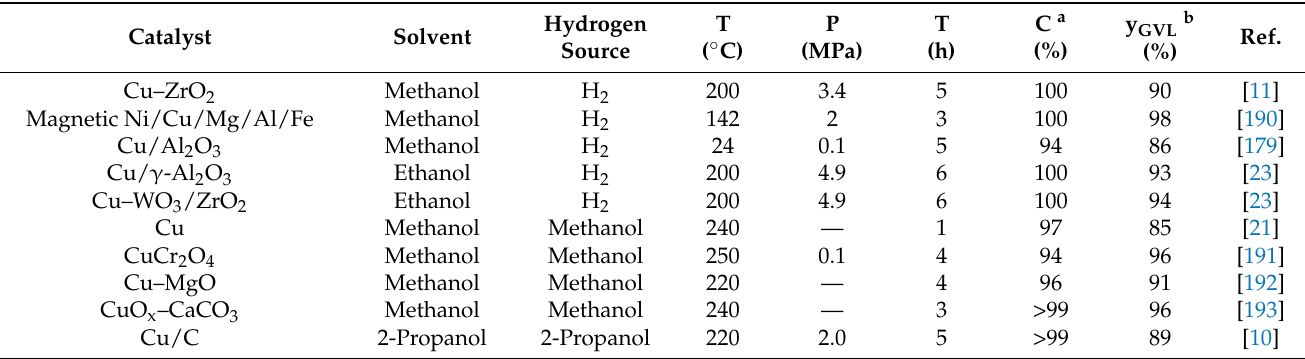
Table 5. Catalytic activity of Cu-based catalysts for hydrogenation of LA to GVL in the presence of